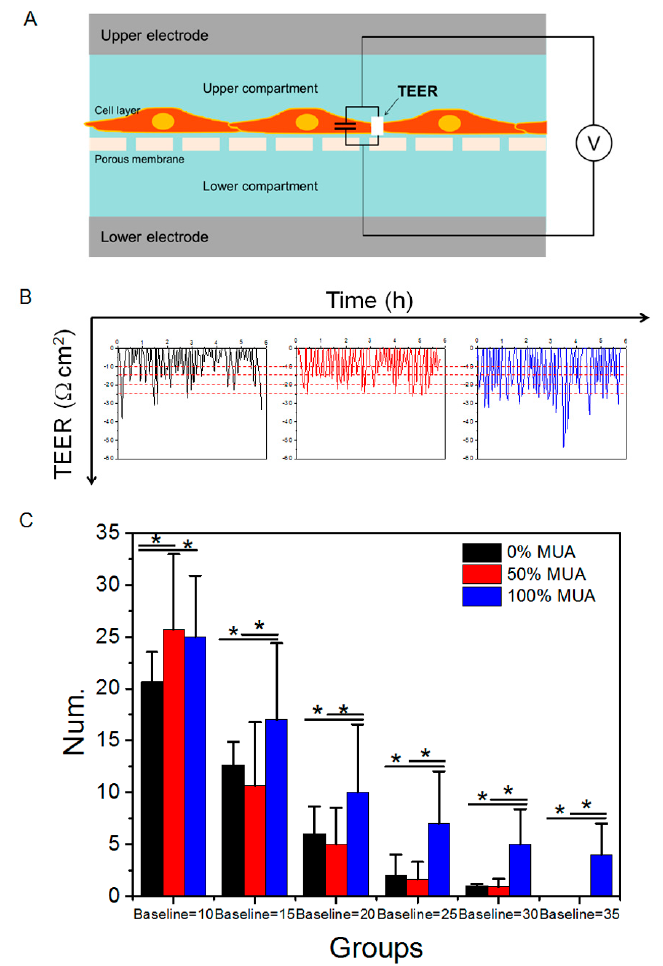
Figure 6. TEER analysis of Caco-2 cell monolayer treated with di ff erent surface-modified GNPs. ( A ) Schematic of TEER test mechanism. ( B ) TEER test curve after exposure to GNPs for 6 h. Red line is chosen baseline. ( C ) Statistical analysis of TEER curve after 6 h. * p <